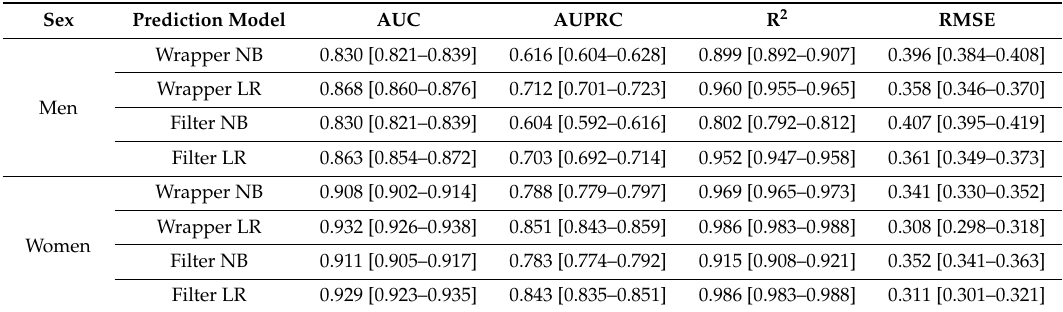
Table 7. Performance analysis results of the four models in men and women.